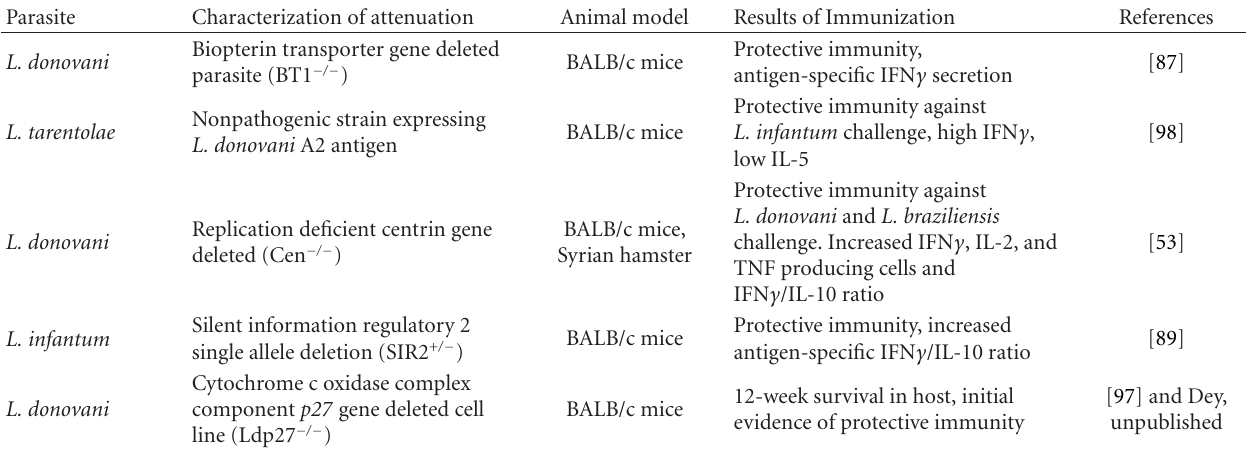
Table 1: Genetically altered live-attenuated vaccine candidates against visceral